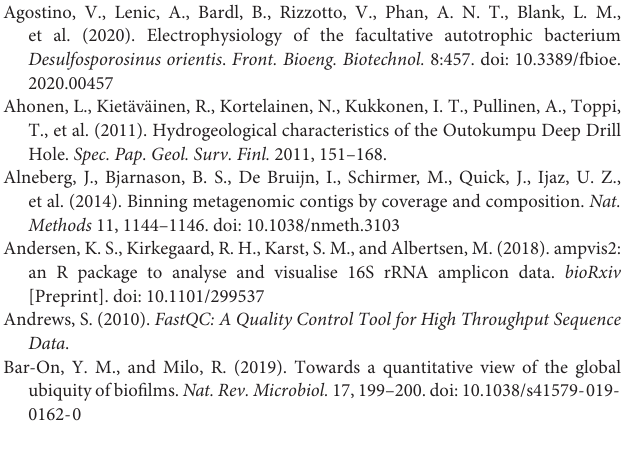
Supplementary Table 2 | Bacterial (A) and fungal community (B) ASV counts across samples.